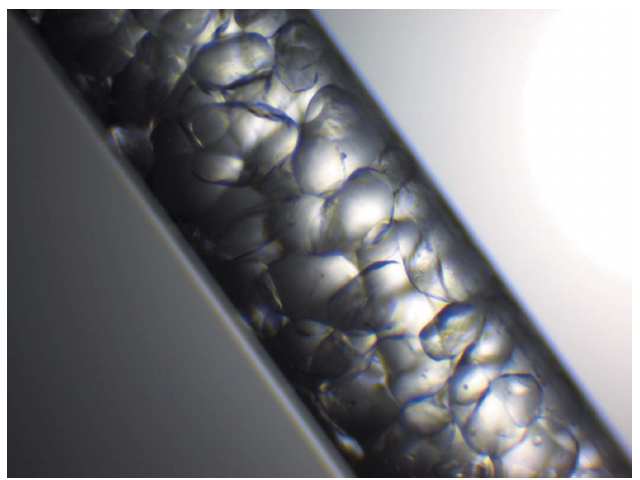
Figure 14 Image of a Hilgenberg capillary (diameter 0.5 mm) filled with crystals of LiNa 3 (SO 4 ) 2 (cid:2) 6H 2 O by means of centrifugal compaction.